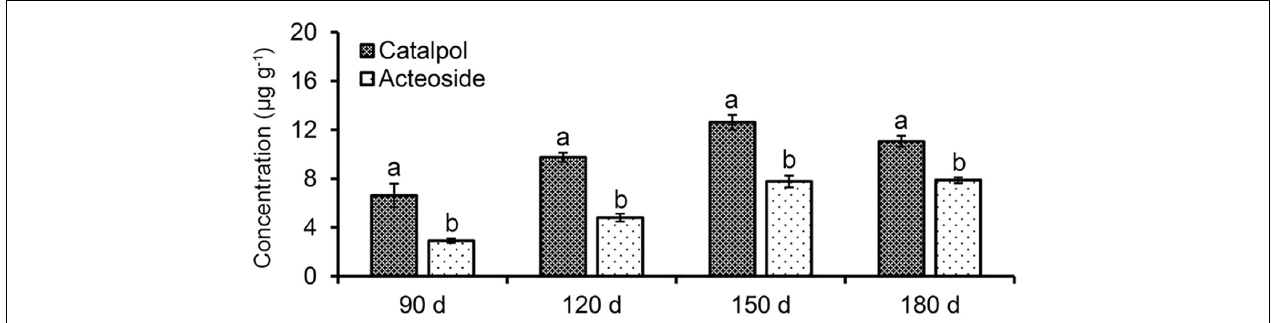
FIGURE 4 | Quantification of catalpol and acteoside in rhizosphere soils at various growth stages of R. glutinosa . Four R. glutinosa growth stages including the beginning of tuber formation, the early stage of tuber expansion, middle stage of tuber expansion and mature tubers at harvest were samples at 90, 120, 150, and 180 days after seedling germination, respectively. Different letters indicate statistical difference ( p < 0.05).